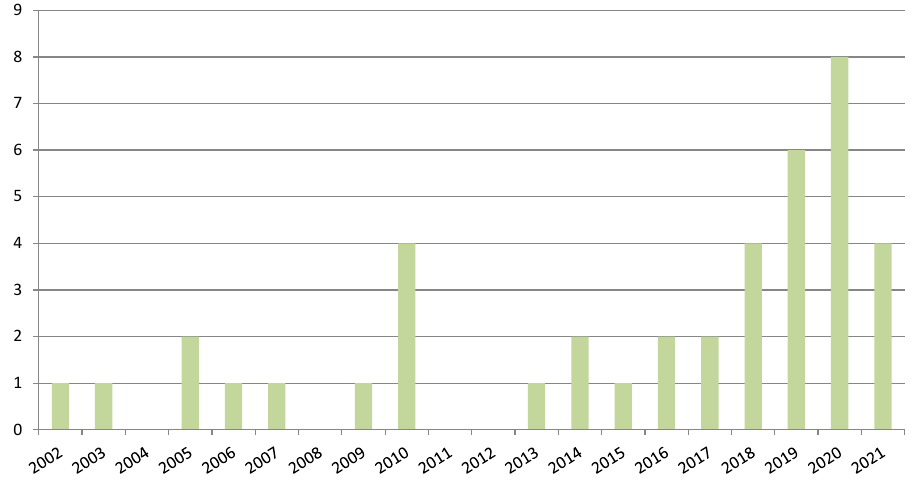
Figure 3. Number of articles published over time.